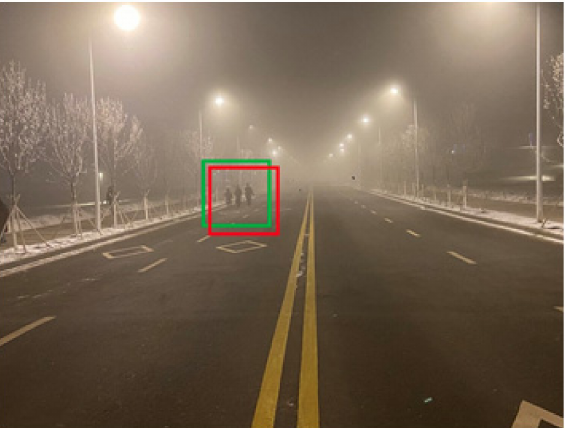
Figure 7. Object detection. The green box represents the ground truth box and the red box represents the prediction